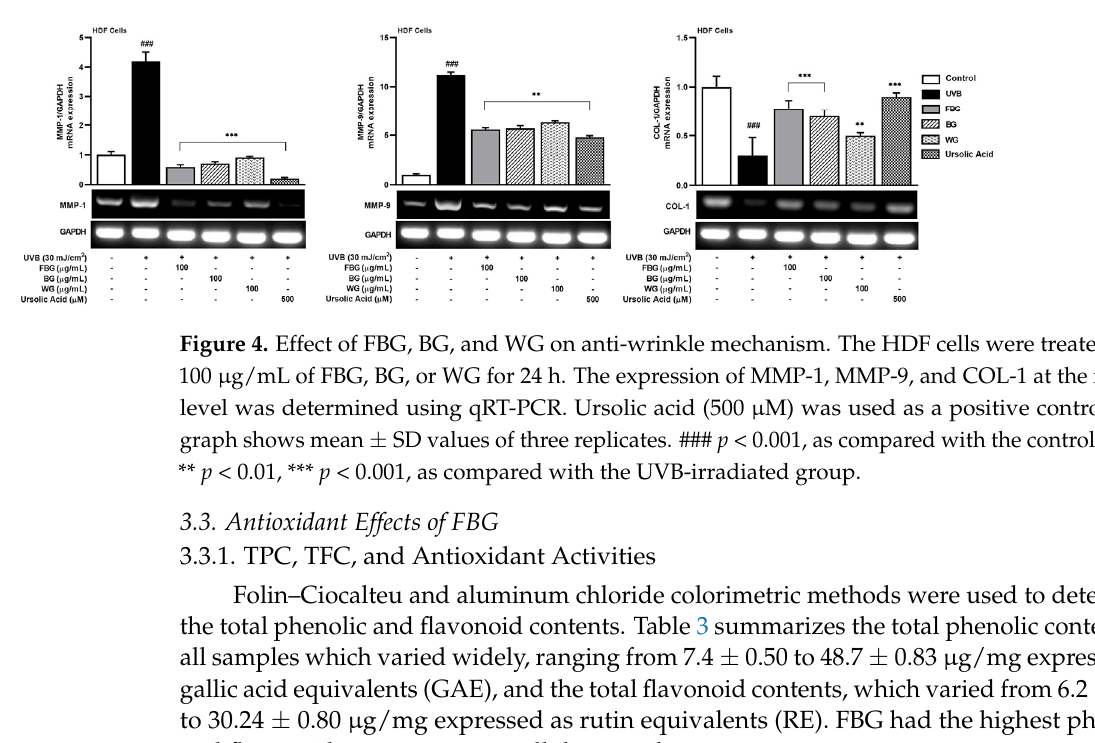
10 of 16 Figure 3. Anti-wrinkle effect of FBG, BG, and WG in HDF cells. ( A ) Cytotoxicity effect of FBG, BG, and WG in HDF cells for 24 h. The cells were treated with each sample at the indicated concentra- tions (50, 100, 200, and 400 μ g/mL) for 24 h. The cytotoxicity effect was then determined with MTT assays. ( B ) Inhibition of elastase was determined in response to the indicated concentration of FBG, BG, and WG (0.5, 1, 2, and 4 mg/mL). ( C ) Intracellular elastase activity in UVB-irradiated HDF cells was measured in response to the concentration of 100 μ g/mL of FBG, BG, or WG, or ursolic acid (500 μ M). The graph shows mean ± SD values of at least three replicates. ### p < 0.001, as compared with the control group; * p < 0.05, ** p < 0.01, as compared with the UVB-irradiated group. We clarified the effects of FBG, BG, and WG on the expression of anti-wrinkle-related